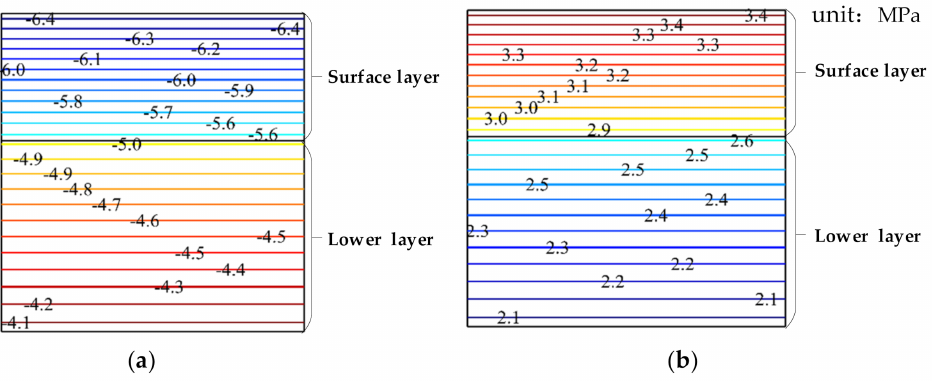
Figure 5. Cloud chart of the horizontal stress (in MPa) varying with the pavement depth; where ( a ) is the case of the water phase transition, and ( b ) is the case of the nonwater phase transition.